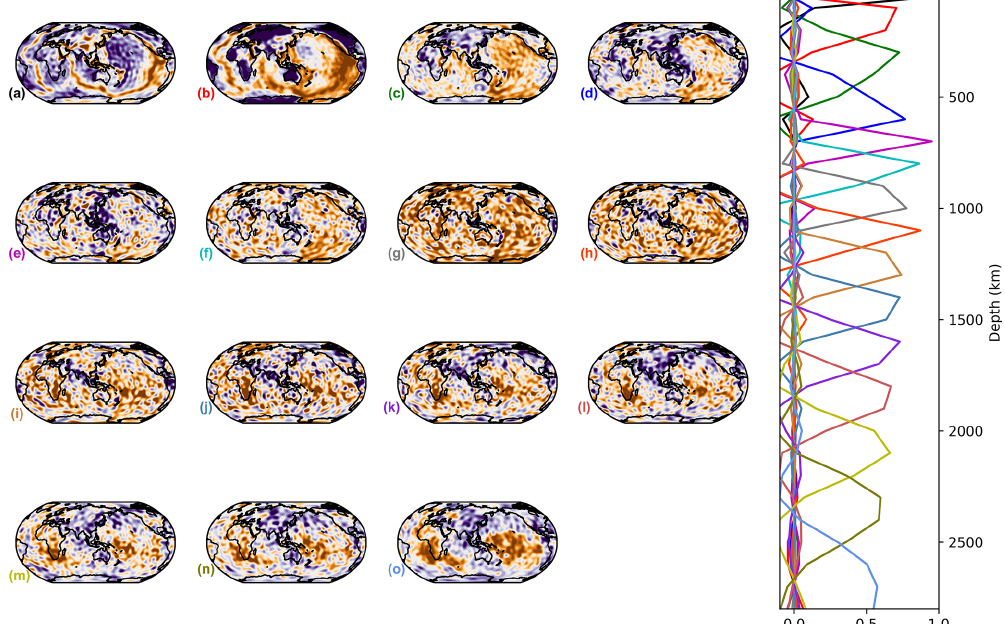
Figure C1. The 15 varimax components of the isotropic part of the SGLOBE-rani model. On the right are the principal components or vertical profiles, and on the left are the associated horizontal structures.